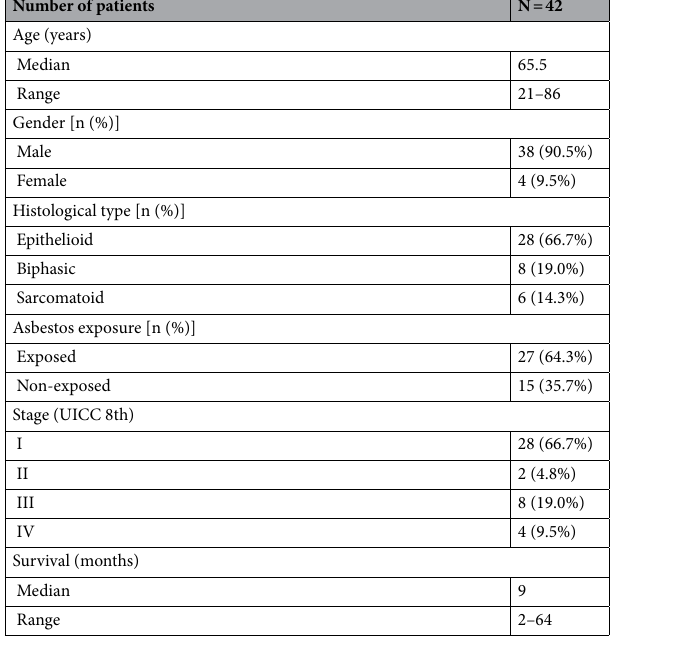
Table 1. Clinicopathological features of MPM